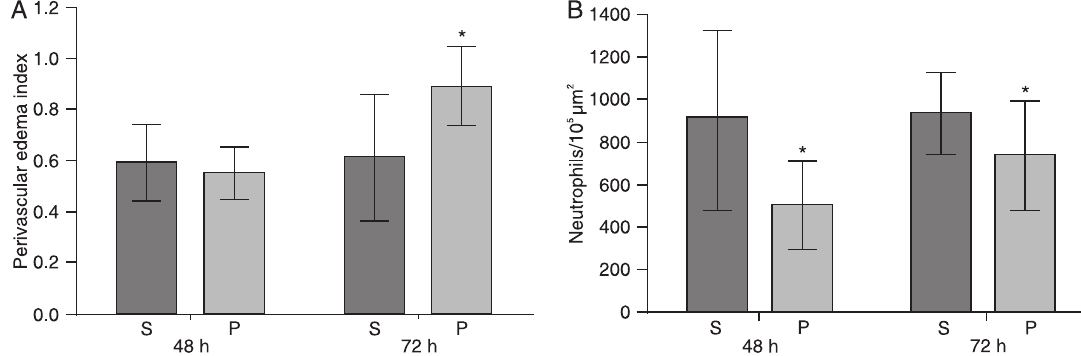
Figure 3. A , Pulmonary edema index graph showing edema formation in rats submitted to pneumonectomy and sacrificed 72 h after surgery. *P < 0.05 compared to all other groups (two-way ANOVA). B , Neutrophil density graph representing the reduction of inflam - matory infiltration 48 and 72 h after pneumonectomy. Data are reported as mean ± CI 95% . S = sham-operated; P = pneumonectomy. *P < 0.05 compared to control groups (two-way